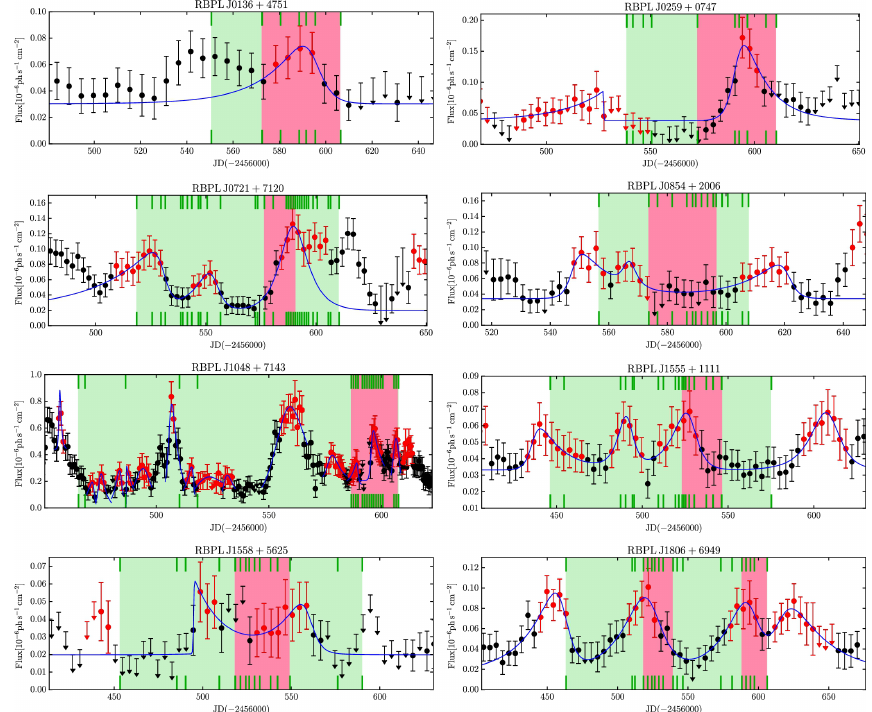
Figure 4. Fermi -LAT γ -ray light curves of a representative sample of 8 blazars monitored by RoboPol. The green areas show the period of RoboPol monitoring; red areas indicate periods of PA rotations. From [63]. Reproduced with kind permission from Oxford University Press and the Royal Astronomical